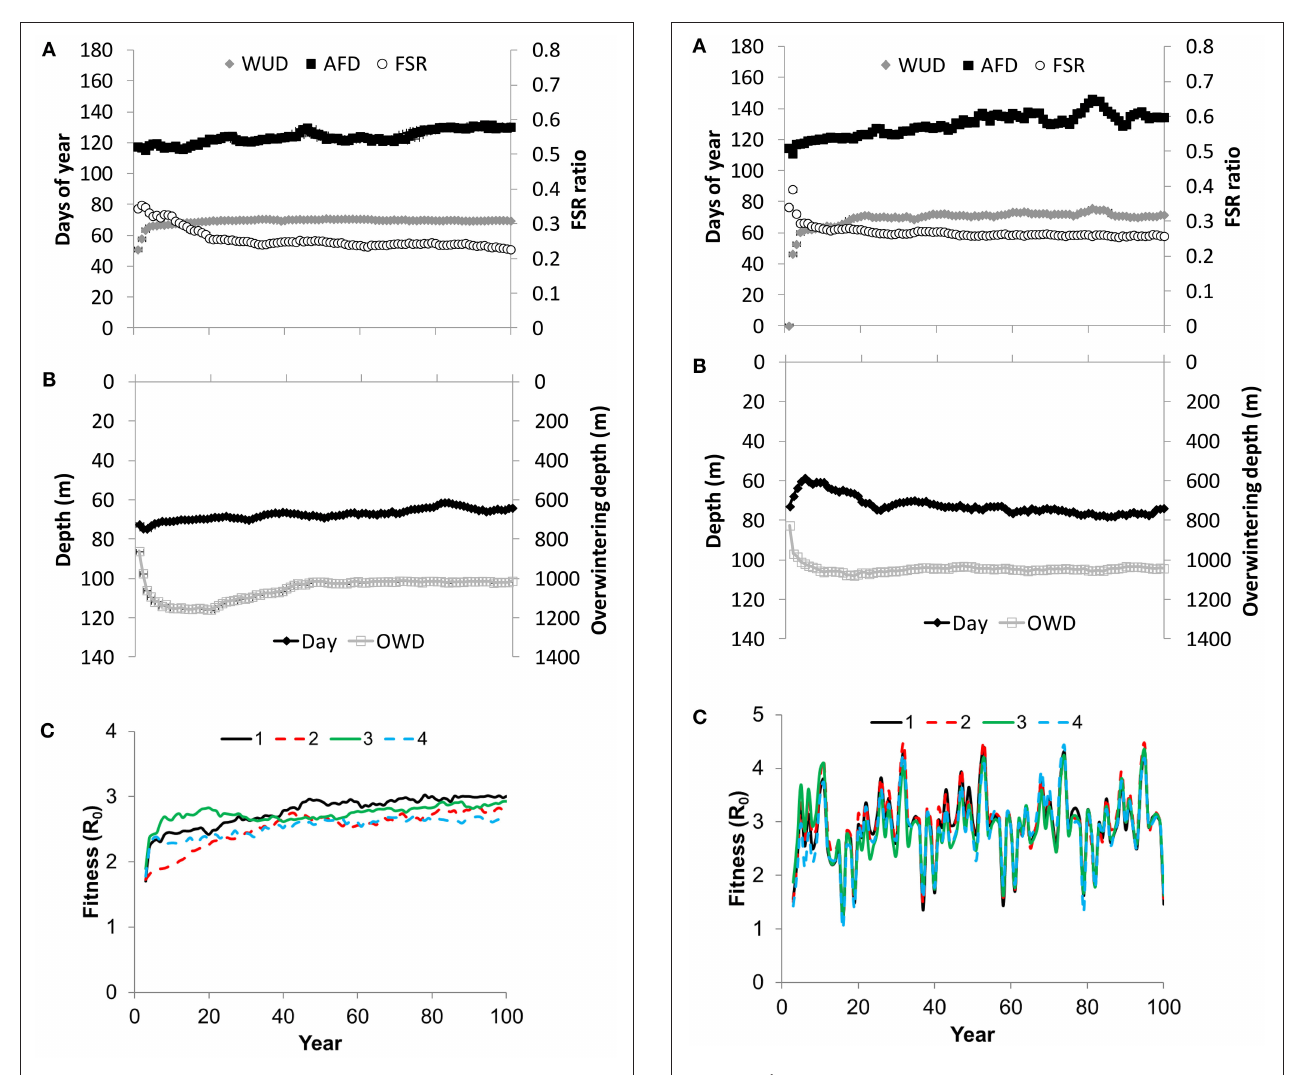
FIGURE 3 | The development over 100 years of the best replicate in simulation 1 in (A) wake up day (WUD), allocation to fat day (AFD) and fat to soma ratio (FSR) traits, (B) the day depth (DD) and overwintering depth (OWD), and (C) fitness (the net reproductive rate, R0) of all four replicates. Values are from end of each year.